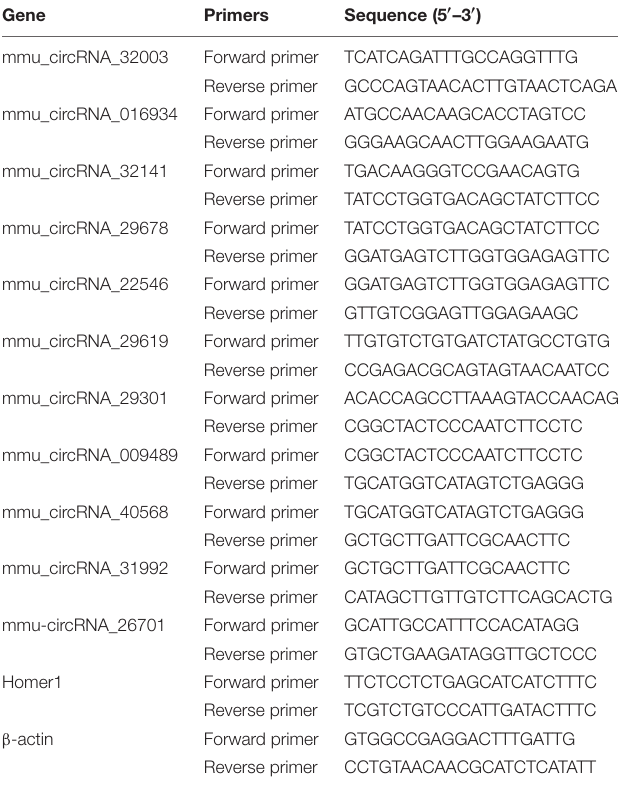
TABLE 1 | The forward and reverse primers for